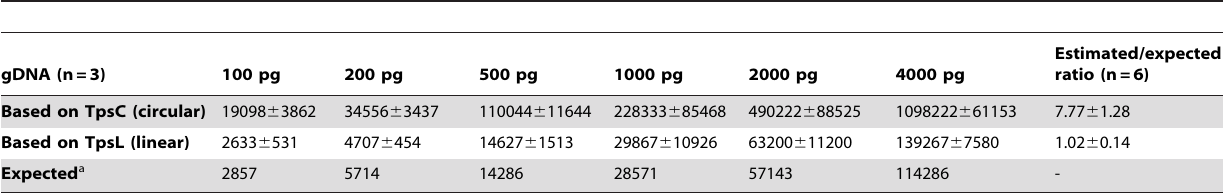
Table 3. QPCR-estimated and expected pcna gene copy numbers (mean 6 standard deviation) in Thalassiosira pseudonana genomic DNA samples based on the circular (TpsC) and linear (TpsL) qPCR standards.